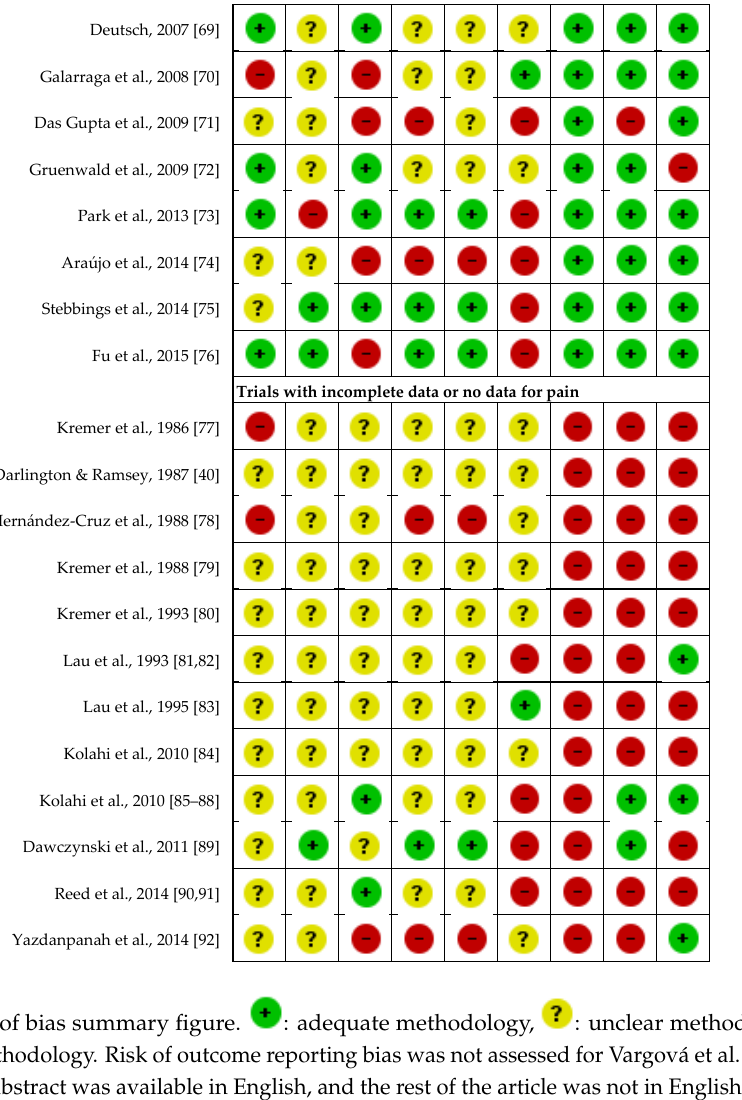
Figure 2. Risk of bias summary figure.